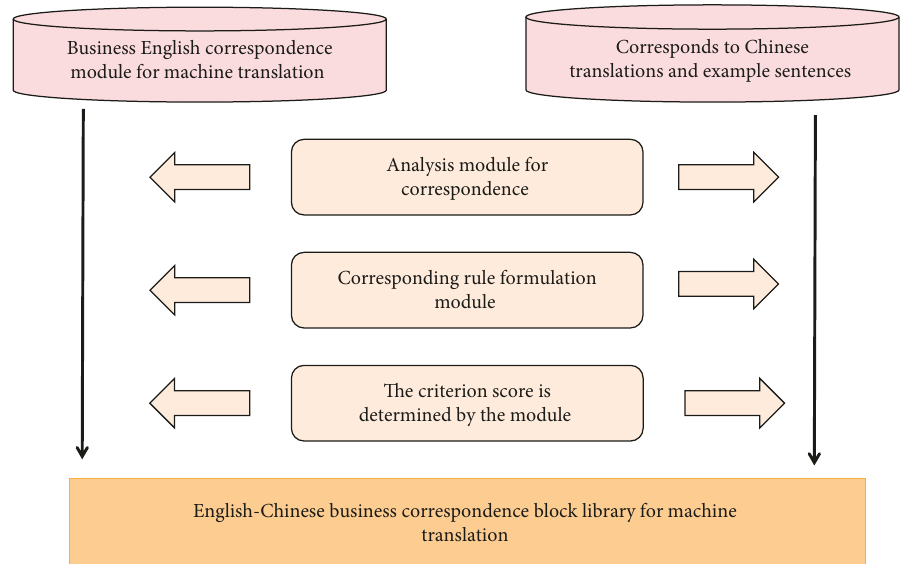
Figure 6: Flow chart of lexical chunk database construction mode.